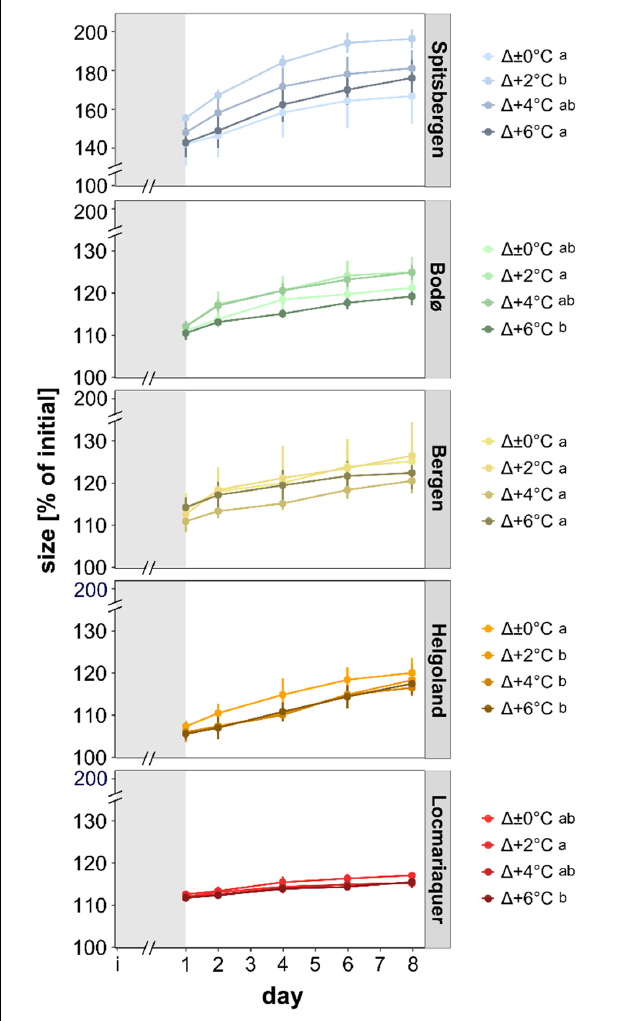
FIGURE 3 | Size (% of initial) of meristematic discs of Saccharina latissima across latitudes in Europe during the temperature-amplitude experiment. Experimental set-up: mean summer SST (control, (cid:49) ± 0 ◦ C) and temperature stress treatments: (cid:49) +2, (cid:49) +4, (cid:49) +6 ◦ C. The gray shading represents the temperature acclimation phase (initial day [i] – day 1). Values are means ± SD ( n = 4). Significant differences are marked by different letters.